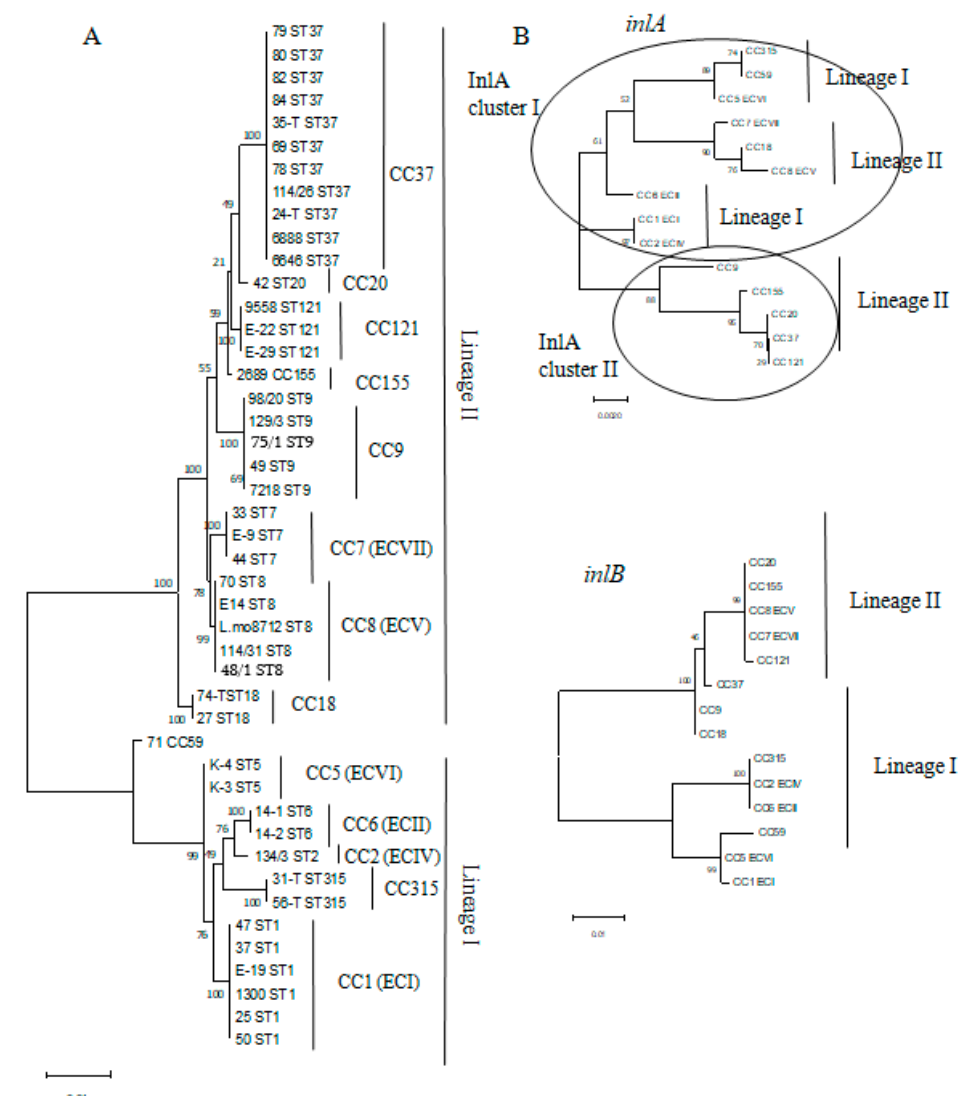
Figure 5. The maximal likelihood trees. ( A )—The dendrogram based on the concatenated sequences of 11 markers included into the MvLST scheme; ( B )—the dendrogram based on the sequences of the internal inlA and inlB gene fragments. The internal inlA fragments formed two clusters designated InlA cluster I and InlA cluster II.